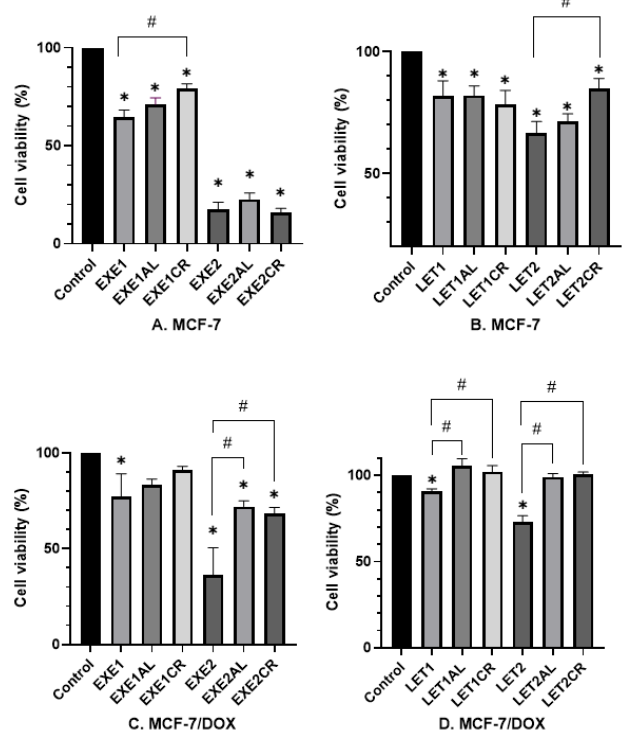
Figure 1. Effect of metalloestrogens and aromatase inhibitors in combination on cell viability. The viability of MCF-7 cells treated with exemestane ( A ) and letrozole ( B ), alone or in combination with aluminum or chromium (III). The viability of MCF-7/DOX cells treated with exemestane ( C ) and letrozole ( D ), alone or in combination with aluminum or chromium (III). EXE1 = 100 µ M; EXE2 = 200 µ M; LET1 = 10 µ M; LET2 =100 µ M; Al/Cr(III) = 100 µ M. The results are presented as mean ± SD, n = 3; p < 0.05; * statistically significant difference from the control; # statistically significant difference from the aromatase